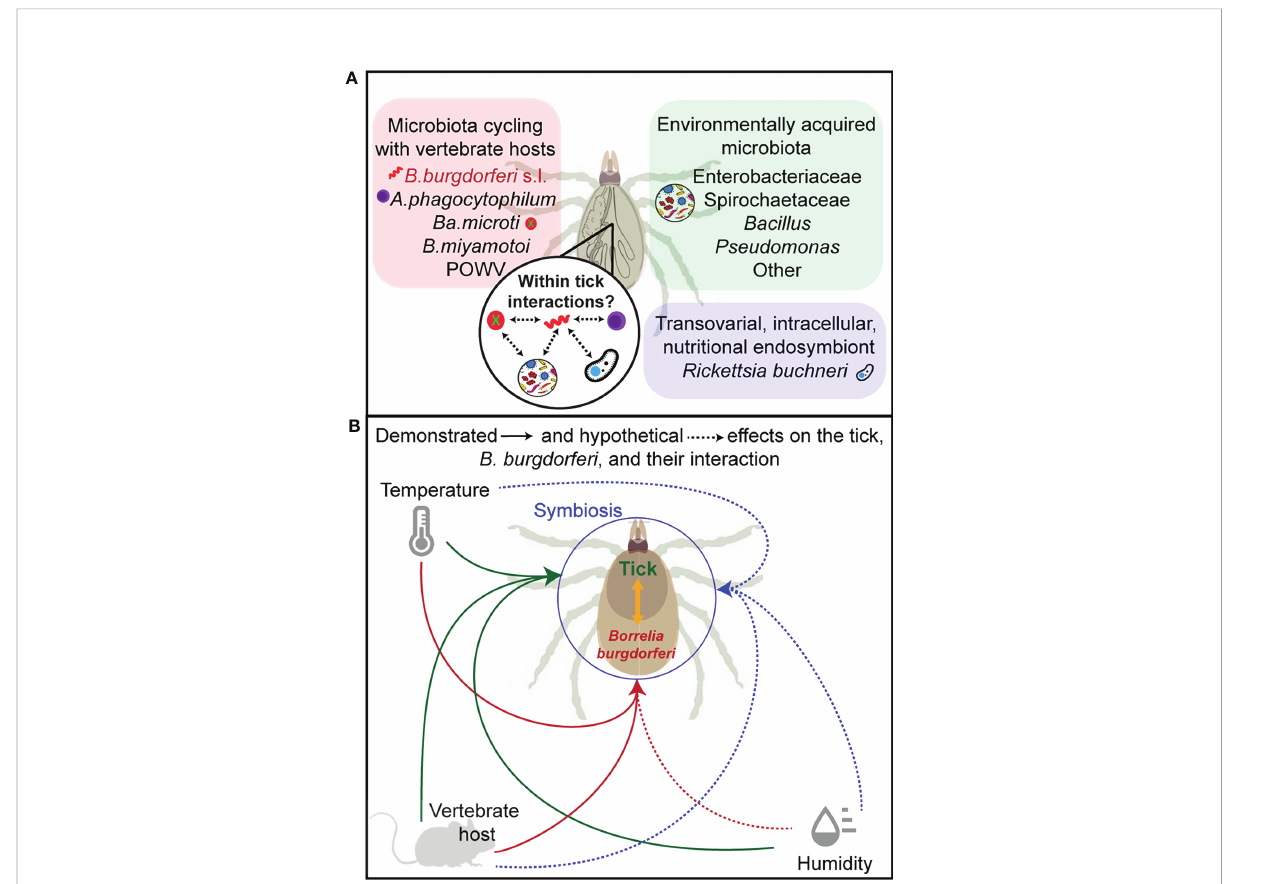
FIGURE 1 Partitioning the microbiome. Panel (A) shows the components of the microbiome in Ixodes scapularis as partitioned by route of transmission including environmental acquisition (green), transovarial transmission (blue), and via a vertebrate blood-meal (pink) ( B. burgdorferi s.l, Borrelia burgdorferi , sensu lato; A. phagocytophilum , Anaplasma phagocytophilum ; Ba . microti , Babesia microti ; B. miyamotoi , Borrelia miyamotoi ; POWV, Powassan virus). Panel (B) illustrates the hypothetical (dashed arrows) and demonstrated (solid arrows) effects on gene expression, phenotypic expression, or fi tness of the tick (green), B. burgdorferi (red), and their symbiotic interactions (blue) for each abiotic factor (temperature and relative humidity), and for vertebrate host factors such as immune response to